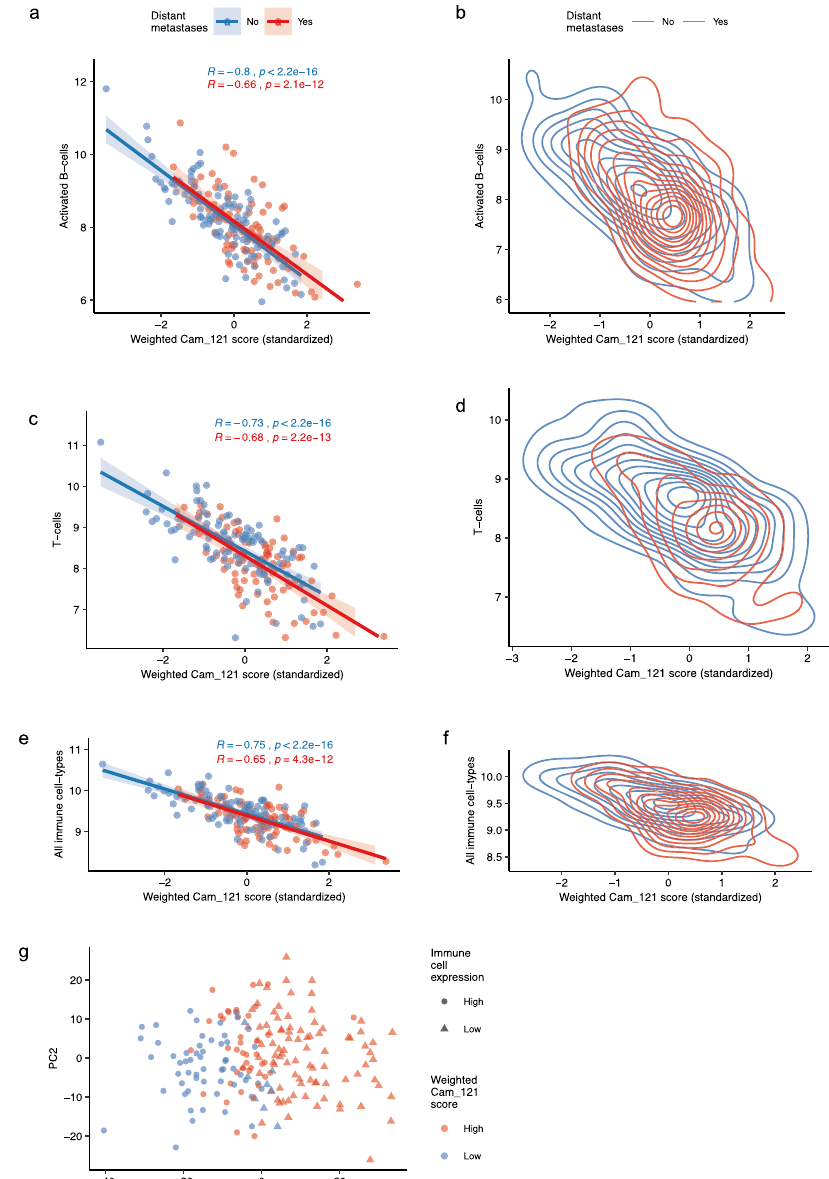
Fig. 4 Weighted Cam_121 score negatively correlates with immune cell expression scores, indicating that a lower weighted signature expression score is associated with a richer immune microenvironment and better prognosis. Scatterplots and density plots showing the relationship between the standardised weighted Cam_121 score ( x -axes) and a , b , the median activated B-cell gene expression ( y -axes), c , d the median T-cell gene expression ( y - axes) and e , f the total immune score (median gene expression of all cell types derived from Angelova et al. 25 , ( y axes). Observations and lines of best fi t are colour-coded according to their metastatic status, with red indicating relapse and blue indicating no relapse. The shaded region in the scatter plots of a , c and e corresponds to the 95% con fi dence interval of the line of best fi t. The two-sided p values from the Pearson correlation coef fi cients are indicated for scatter plots. g Scatterplot of the scores of the observations on the two- fi rst dimensions of a PCA analysis on the overall immune cell expression data. Observations are colour-coded according to their weighted Cam_121 expression score ( “ high ” / ” low ” classi fi cation based on a quantile 0.33 split, indicated in red/yellow, respectively). Different symbols are used for observations with “ high ” (circles) and “ low ” (triangles) immune cell expression levels based on a median split. Source data are provided as a Source data fi